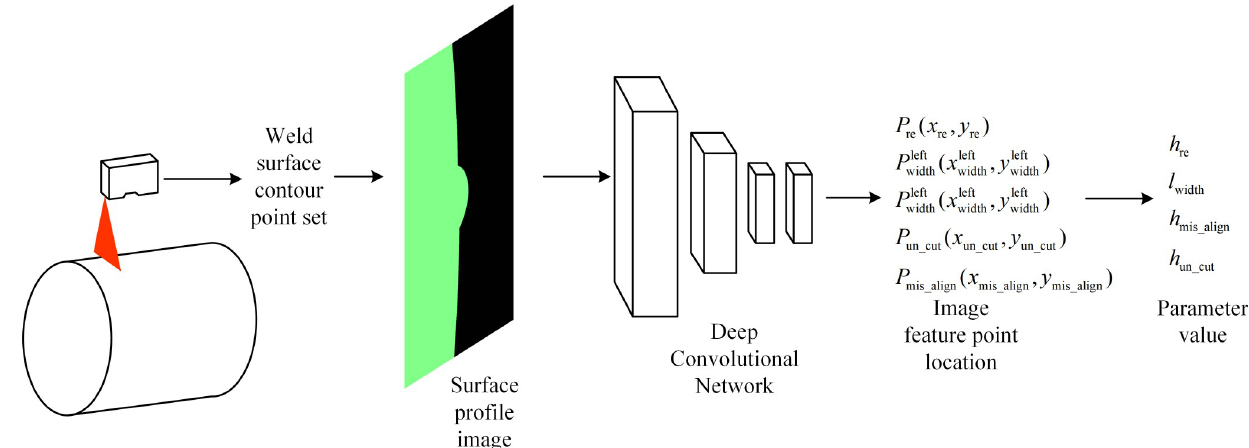
Fig 2. Flowchart of the laser profile sensor-based welding seam surface profile parameter detection